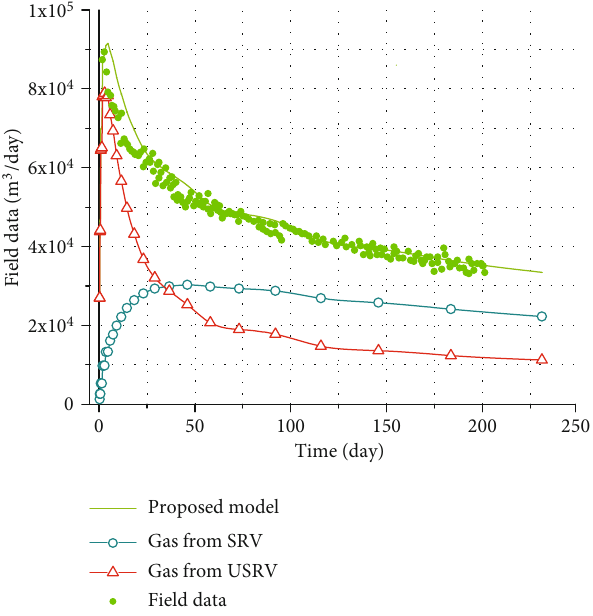
Figure 6: History matching results for fi eld data gathered from the Marcellus